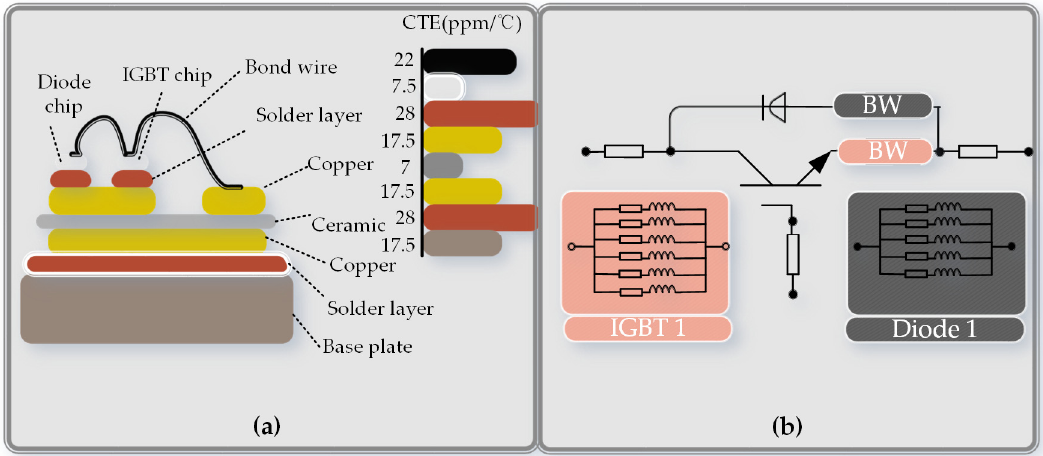
Figure 1. ( a ) The structure of the IGBT (insulated-gate bipolar transistor) module. ( b ) Equivalent model of the IGBT Figure 1. (a) The structure of the IGBT module. (b) Equivalent model of the IGBT bond wires. bond